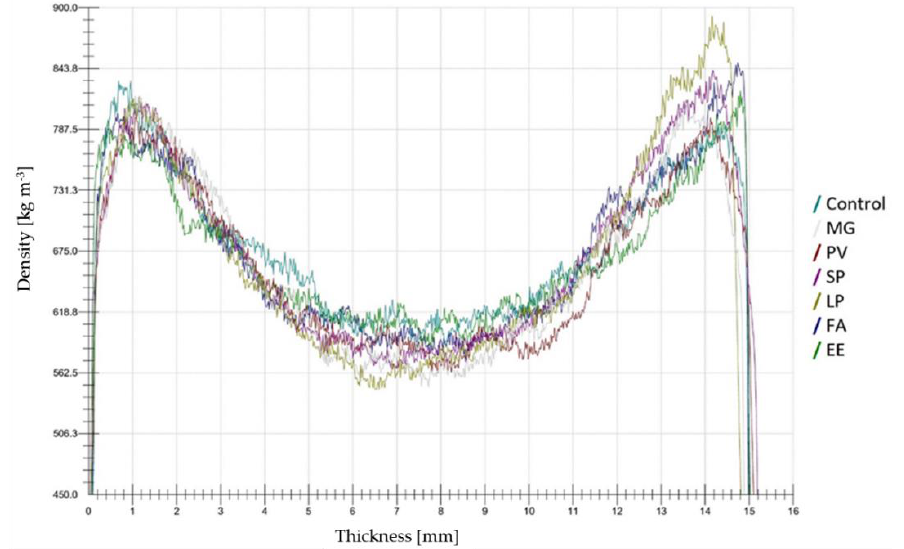
Figure 8. Density profiles of tested boards. FA— Festuca arundinacea , EE— Elymus elongatus , LP— Lolium perenne , MG— Miscanthus x giganteus , PV— Panicum virgatum , SP— Spartina pectinate .